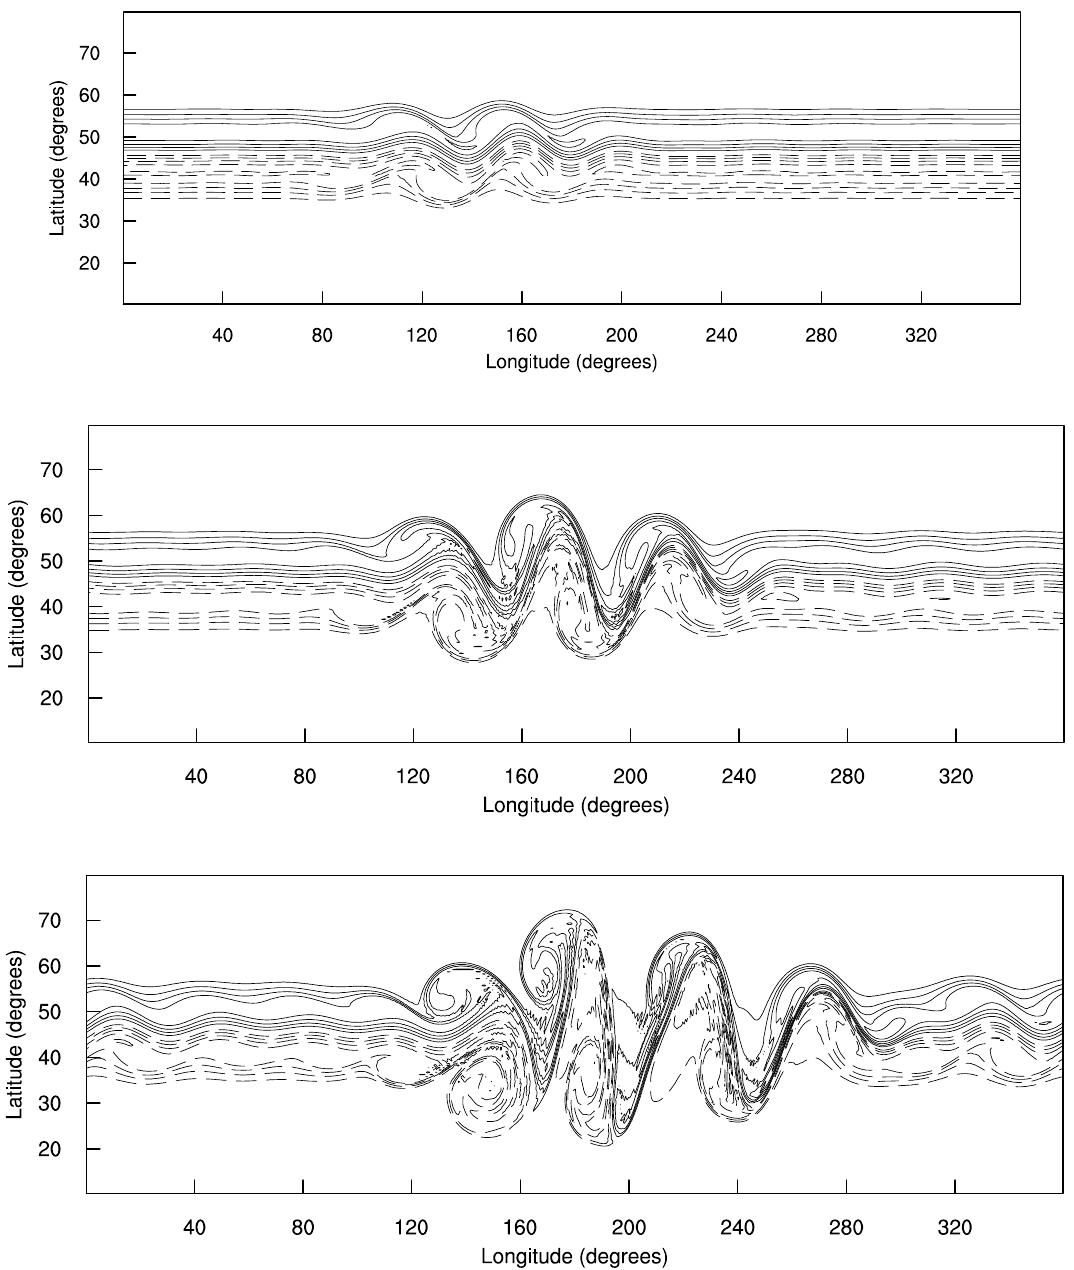
Figure 7. Vorticity forecasts at 96 h ( top ), 120 h ( middle ), and 144 h ( bottom ).